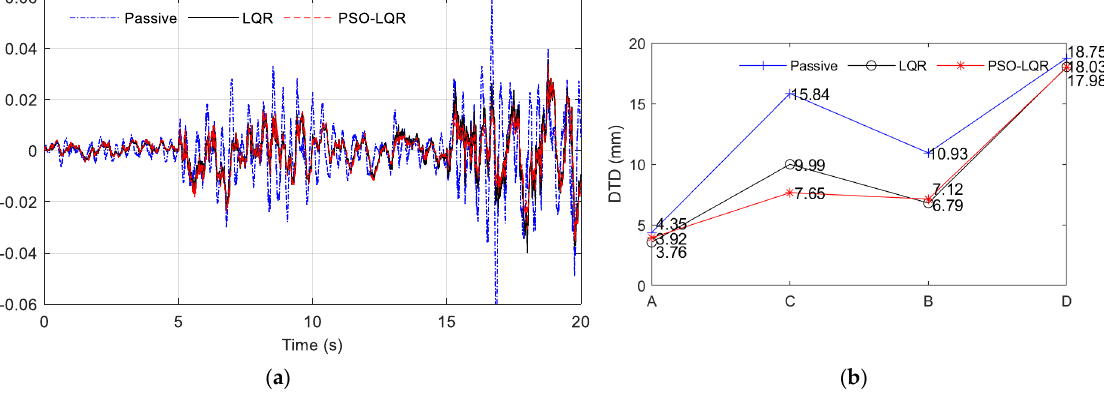
Figure 18. DTD comparison diagram of mode switching on the variable road surface. (a) Time domain variation curve of A–C–B–D road section. (b) RMS value of A–C–B–D road section.